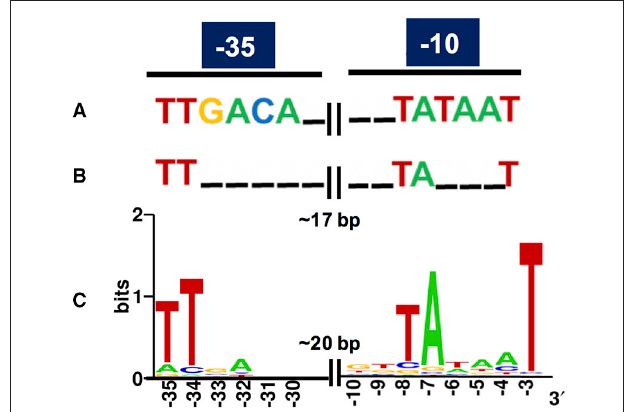
FIGURE 4 | Consensus of RpoD-related metagenomic promoters. (A) Known consensus sequences of the RpoD-dependent promoter determined in vitro , TTGACA ( − 35) and TATAAT ( − 10) separated by 17 plus/minus 2 bp in E. coli (Shimada et al., 2014). (B) Known consensus sequences of 582 promoters experimentally validated in E. coli (Shimada et al., 2014; Gama-Castro et al., 2016; Keseler et al., 2017). (C) The sequences of the 33 promoters experimentally validated in this study were aligned and subjected to Logo analysis ( Crooks et al., 2004). The consensus from the metagenomic set (C) is very similar to the one from the experimentally validated set from E. coli (B)